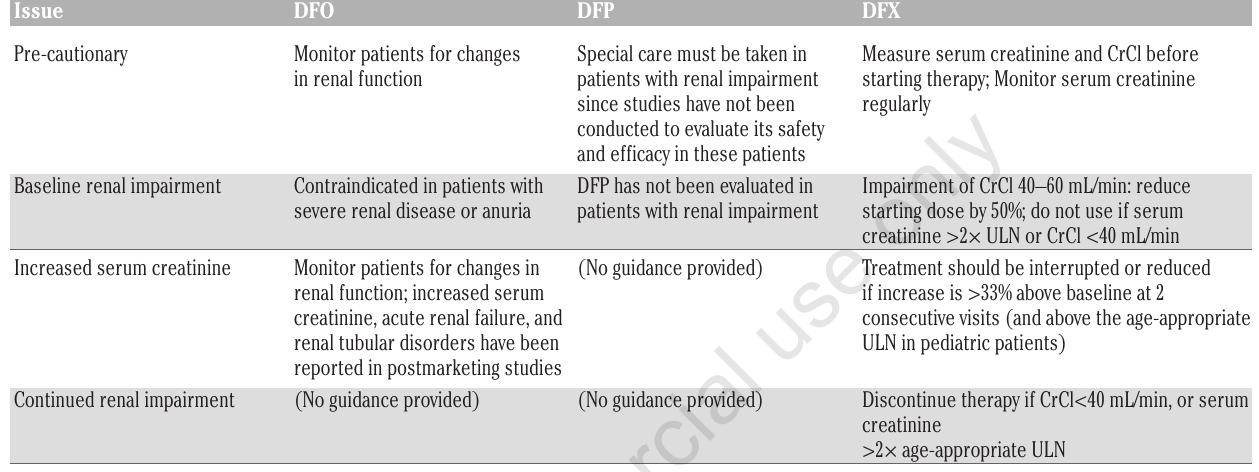
Table 2. Factors hindering proper meta-analyses for renal biomarkers in thalassemia studies. Factors affecting proper meta-analysis construction for renal biomarkers in thalassemia Majority of studies have small sample size (<10 to 500) Different parameters and definitions are used for different renal injury markers Different techniques are used to detect same biomarkers across studies Populations studied are not homogeneous (age, ICT use, transfusion burden, splenectomy, hemoglobin levels, iron overload status) Studies do not account for concomitant medication (calcium, vitamin D, ICT, etc.) Other kidney diseases can affect results and not always accounted for (hep C, diabetes, etc.)